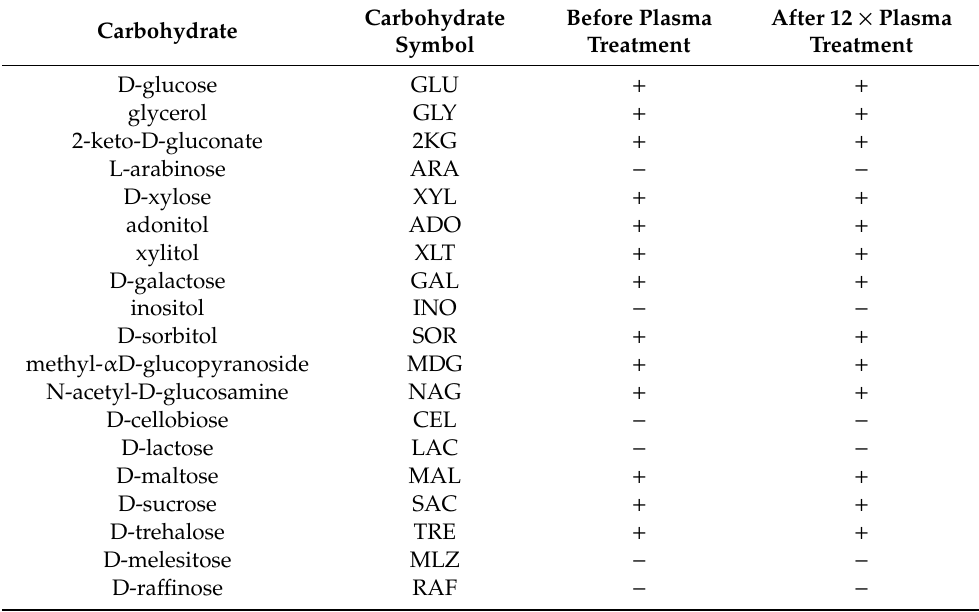
Table 2. The ability of the tested strain to absorb carbon from 19 carbohydrates, assessed using the API 20C AUX